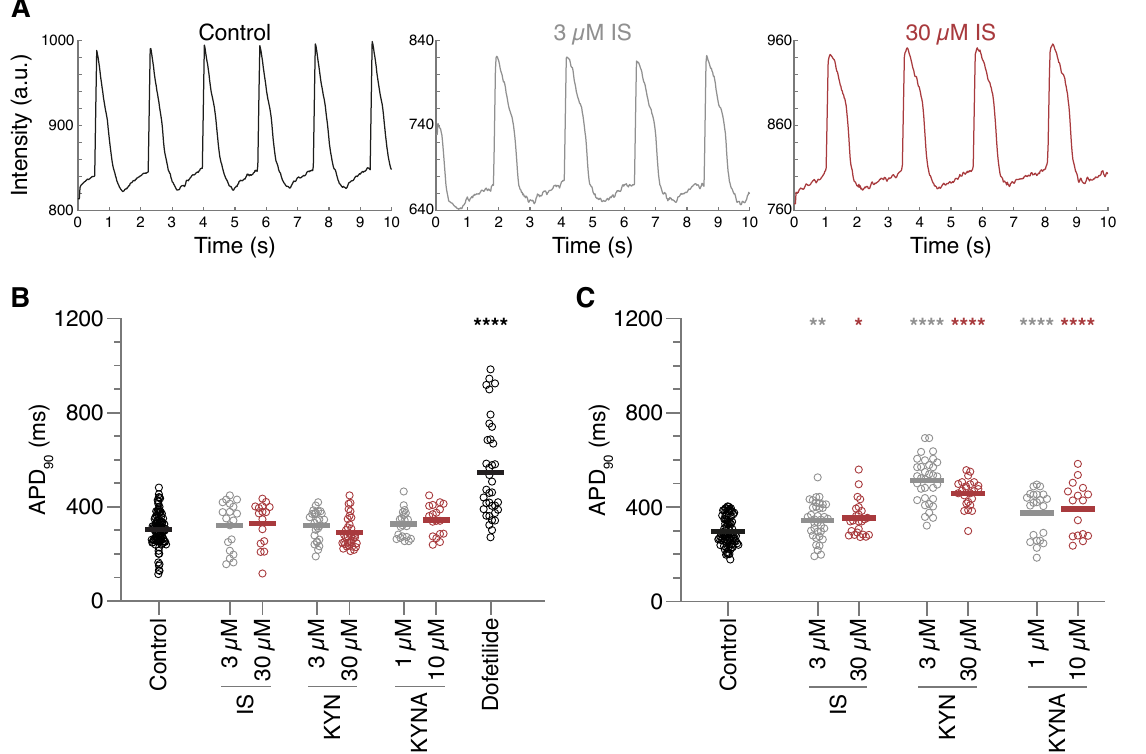
Figure 1. Action potential prolongation induced by chronic uremic toxin exposure. Action potential duration (APD) was measured in spontaneously beating cells, using a voltage sensitive dye, after exposure to two concentrations of indoxyl sulfate (IS), kynurenine (KYN), or kynurenic acid (KYNA). ( A ) Representative action potential traces of chronic exposure measurements in control, 3 µ M IS, and 30 µ M IS. ( B ) Quantified APD measurements after acute uremic toxin (UT) exposure of 5 min. ( C ) Quantified APD measurements after chronic 48-h UT exposure. Data are shown as means with individual measurements, and quantified APDs were corrected for beating rate. Measurements were obtained in three independent differentiations of hiPSC-CMs, with numbers of cells = 16–99 ( B ), and 16–82 ( C ). * p < 0.05, ** p < 0.01, **** p < 0.0001 compared to